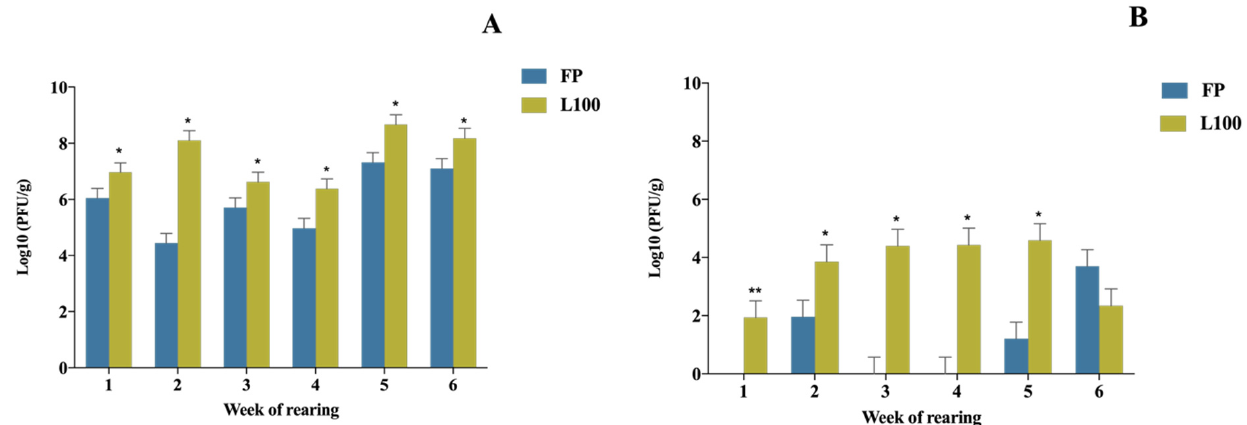
Figure 2. Concentration of BPs recovered following administration depending on the week of application and organ analysed: ( A ) the crop, ( B ) the PV-gizzard. Values are presented as Log10 (PFU/g). Error bars show one standard deviation. The statistically significant differences between groups comparing BP delivery method have been represented as * ( p -value < 0.05) and ** ( p -value < 0.001).